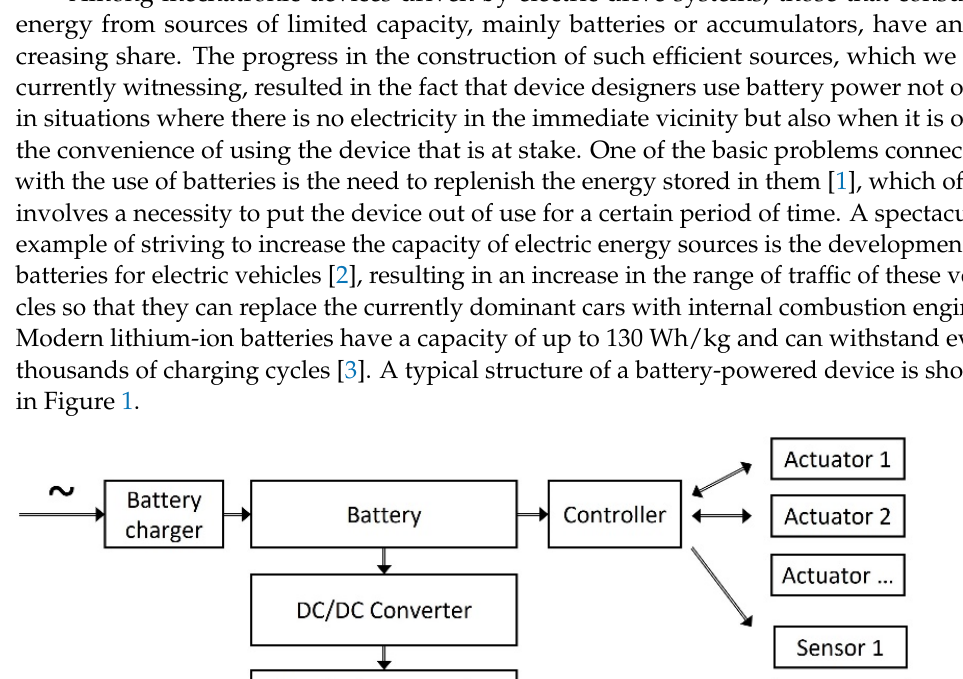
Figure 2. The orthotic robot designed and manufactured at the Division of Design of Precision Devices at the Faculty of Mechatronics, the Warsaw University of Technology. In the case of devices used for movement generation, actuators have the largest share in the balance of power drawn from the battery. In the presented robot, it amounts to more than 90% of the average consumption, which results from the power of the drive systems amounting to more than 400 W, whereas the power necessary to supply controllers and measuring systems does not exceed 20 W. For this reason, when trying to reduce this consumption, it is worth dealing with the actuators in the first place. During the work on the orthotic robot, a special simulation model of the actuators of the robot was used for this purpose. 2. Materials and Methods 2.1. Simulation Research of the Robot 2.1.1. Model of the Robot The structure of the model is shown in Figure 3. The MATLAB/Simulink package was used as the basic modelling tool. The key to the description of the mechanical structure of the orthotic robot was the use of the SimMechanics software, which enables modelling